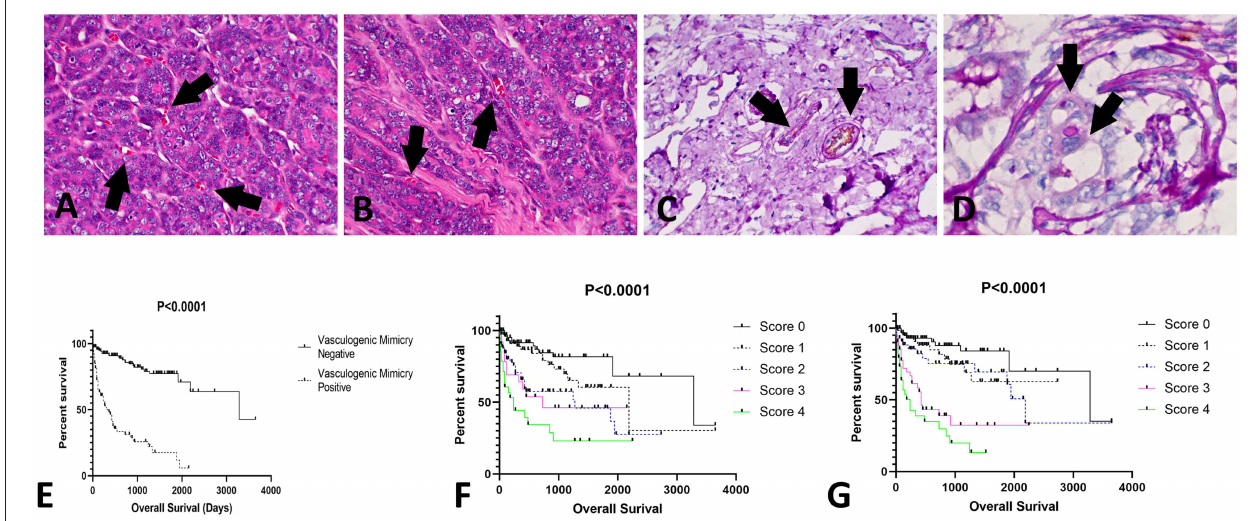
FIGURE 2 | Evaluation of vasculogenic mimicry (VM) in canine mammary gland tumors. (A,B) Histological appearance of tubular—like structures formed by neoplastic cells with red blood cells in the lumen (arrows); 200 × . (C) Positive internal control for CD31/PAS double staining. Note the double positivity for both CD31 (brown staining) and PAS (pink staining) (arrows); 200 × . (D) Tubular-like structure (arrows) formed by neoplastic epithelial cells positive for PAS; 400 × . (E) Overall survival of patients with tumors positive or negative for VM structures. Patients with tumors presenting with VM experienced shorter survival times ( P < 0.0001). In addition, we identified associations of VEGF-A and VEGFR-2 expression with survival time. Patients with higher scores (3 or 4) for VEGF-A (F) or VEGFR-2 (G) experienced shorter survival times.